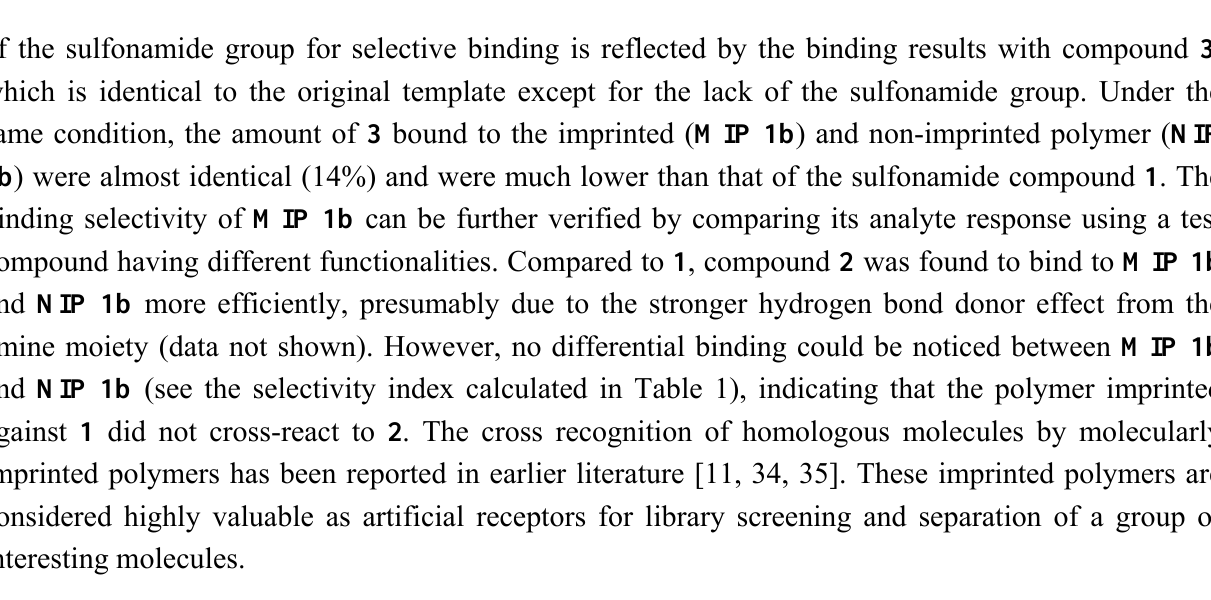
Table 1. Preparation and characterization of molecularly imprinted polymers using template 1 .